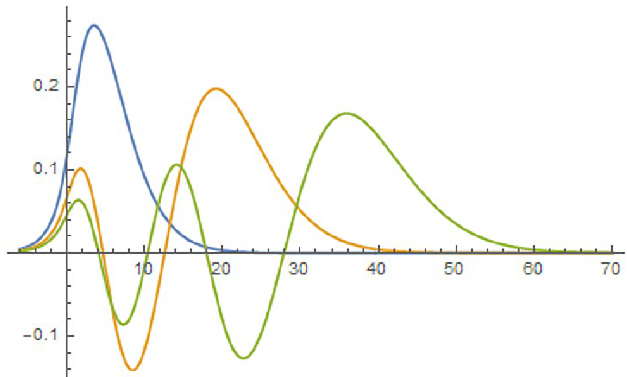
Fig. 4. Three leading wave function (n = 1,3,5) as a function of ln q 2 with running coupling constant and Higgs mass regulator.